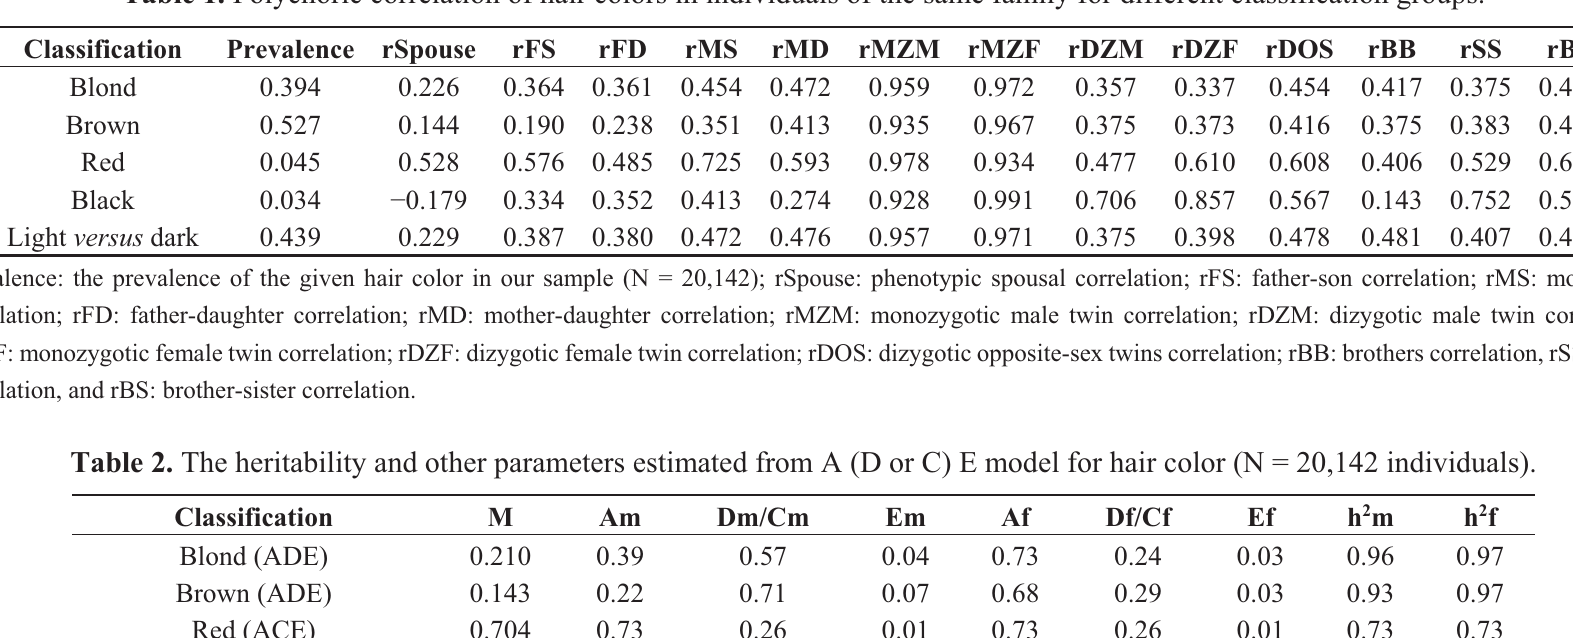
Table 1. Polychoric correlation of hair colors in individuals of the same family for different classification groups.